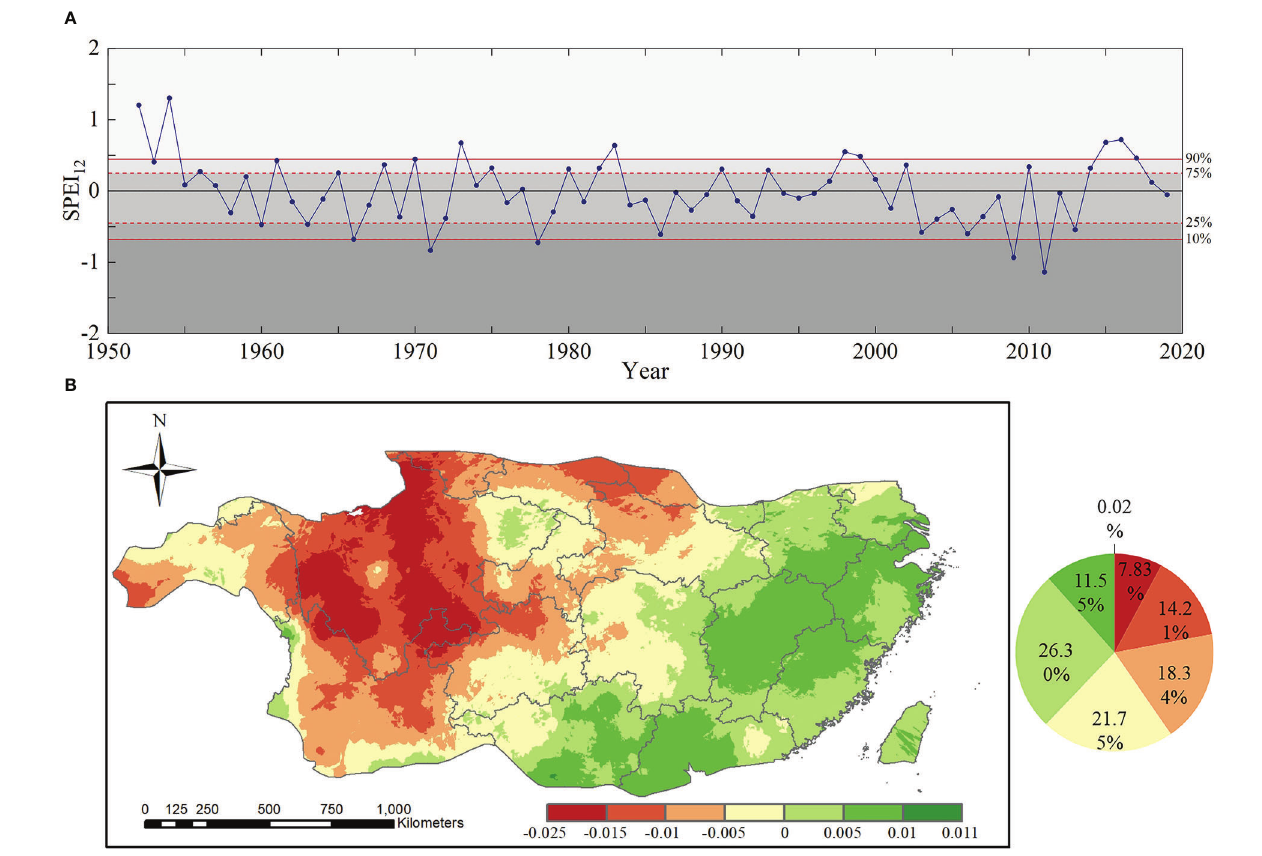
FIGURE 3 Spatiotemporal trend of SPEI 12 : (A) Time series and percentiles of drought conditions of SPEI 12 from 1952 to 2019 (the solid red lines at the 10th and 90th percentiles represent thresholds for extreme drought and extreme wetness, respectively, and the dashed red lines at the 25th and 75th percentiles represent thresholds for moderate drought and moderate wetness, respectively and different regions represent different drought conditions); and (B) spatial variation trend of subtropical drought from 1952 to